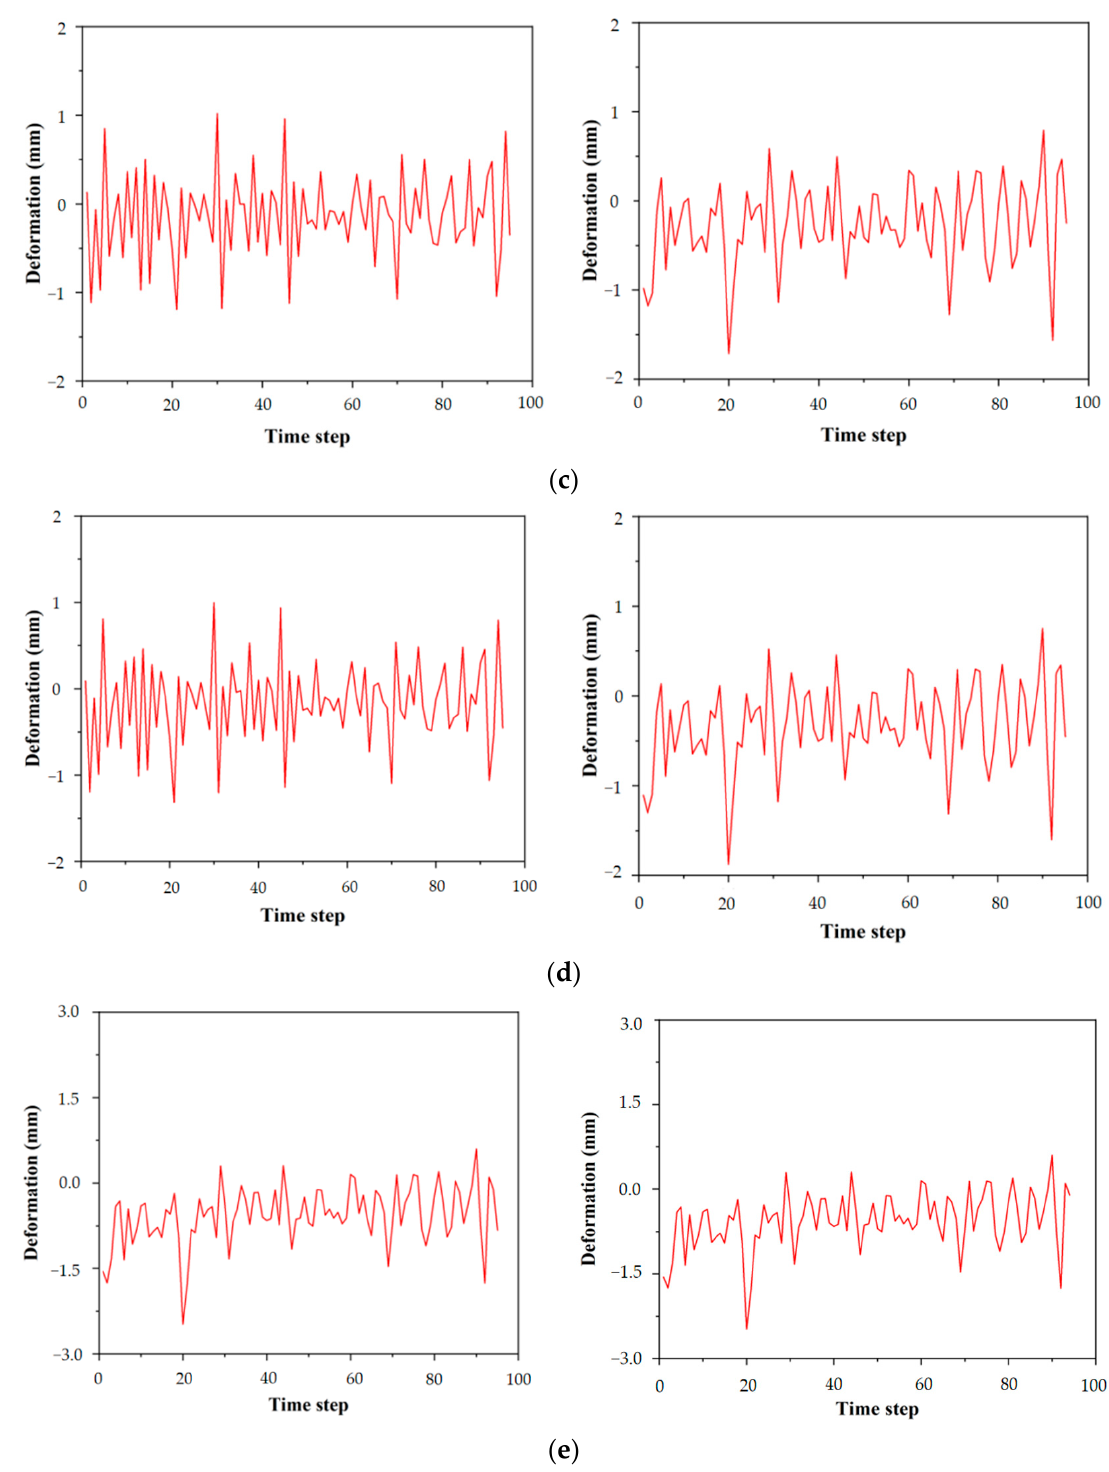
Figure 14. First difference and second difference for the data of five points. ( a ) First difference and second difference for Point 1; ( b ) First difference and second difference for Point 2; ( c ) First difference and second difference for Point 5; ( d ) First difference and second difference for Point 8; ( e ) First difference and second difference for Point 9.